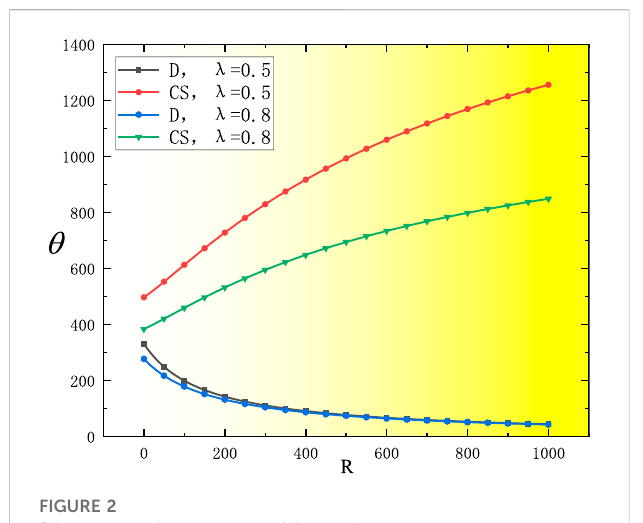
FIGURE 4 R impacts on retailer pro fi